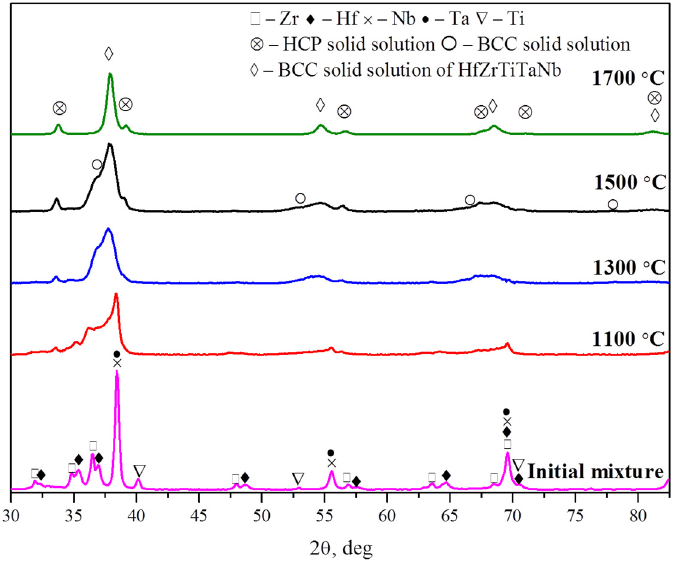
Figure 1. XRD patterns of initial HfTaTiNbZr powder blend and HfTaTiNbZr bulk specimens sintered at different temperatures (indicated). HCP, hexagonal closest packed; BCC, body-centered cubic.